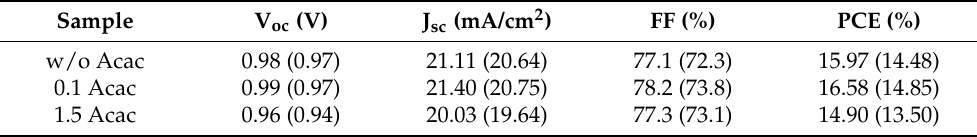
Figure 10. J–V curves of ITO/Cu:NiO x /perovskite/PC 60 BM/BCP/Ag devices under 1 sun simulated light for Cu:NiO x films fabricated from precursor containing ( a ) 0.1 and 1.5 molar ratio of fuel (Acac) to oxidizer (Cu, Ni nitrates) annealed at 150 and 200 °C, and from precursor containing ( b ) w/o Acac, 0.1, and 1.5 molar ratio of fuel (Acac) to oxidizer (Cu, Ni nitrates) annealed at 300 °C. Table 1. Extracted solar cell parameters of the best ITO/Cu:NiO x /perovskite/PC 60 BM/BCP/Ag de ‐ vices. The average values of 12 devices for each batch are shown in brackets.